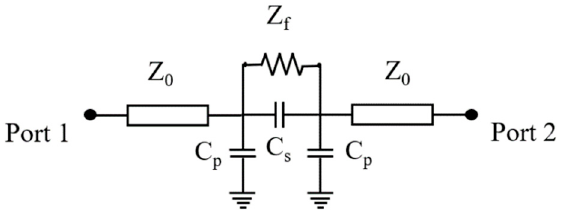
Figure 3. Circuit model representation of the microstrip line with gap including film.